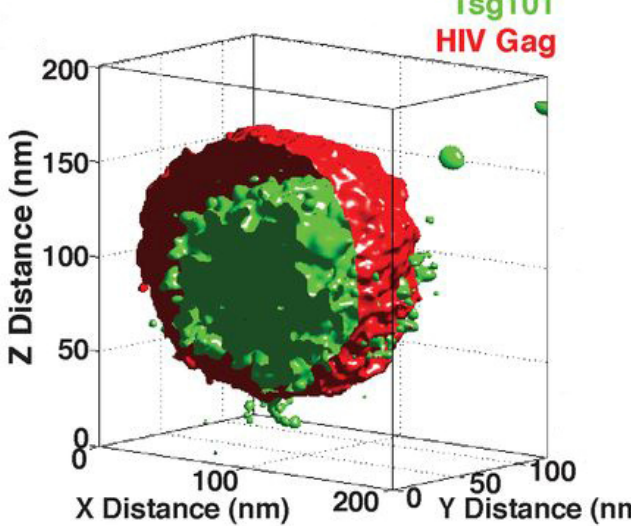
Figure 3. The Molecular Architecture of HIV. An averaged 3D probability density map displaying the distribution of Gag and TSG101 in nascent HIV virus like particles, adapted from Distribution of ESCRT Machinery at HIV Assembly Sites Reveals Virus Scaffolding of ESCRT Subunits [33]. Reprinted with permission from